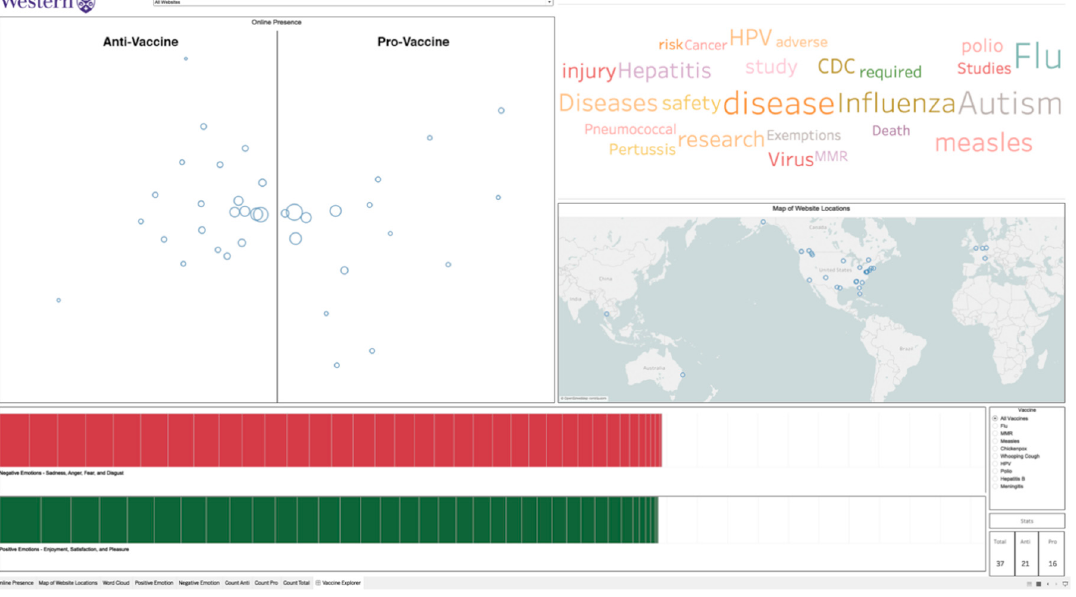
Figure 1. Screenshot of VINCENT. Top left: online presence map. Top right: word cloud. Middle right: map of website locations. Bottom: emotion bar chart.